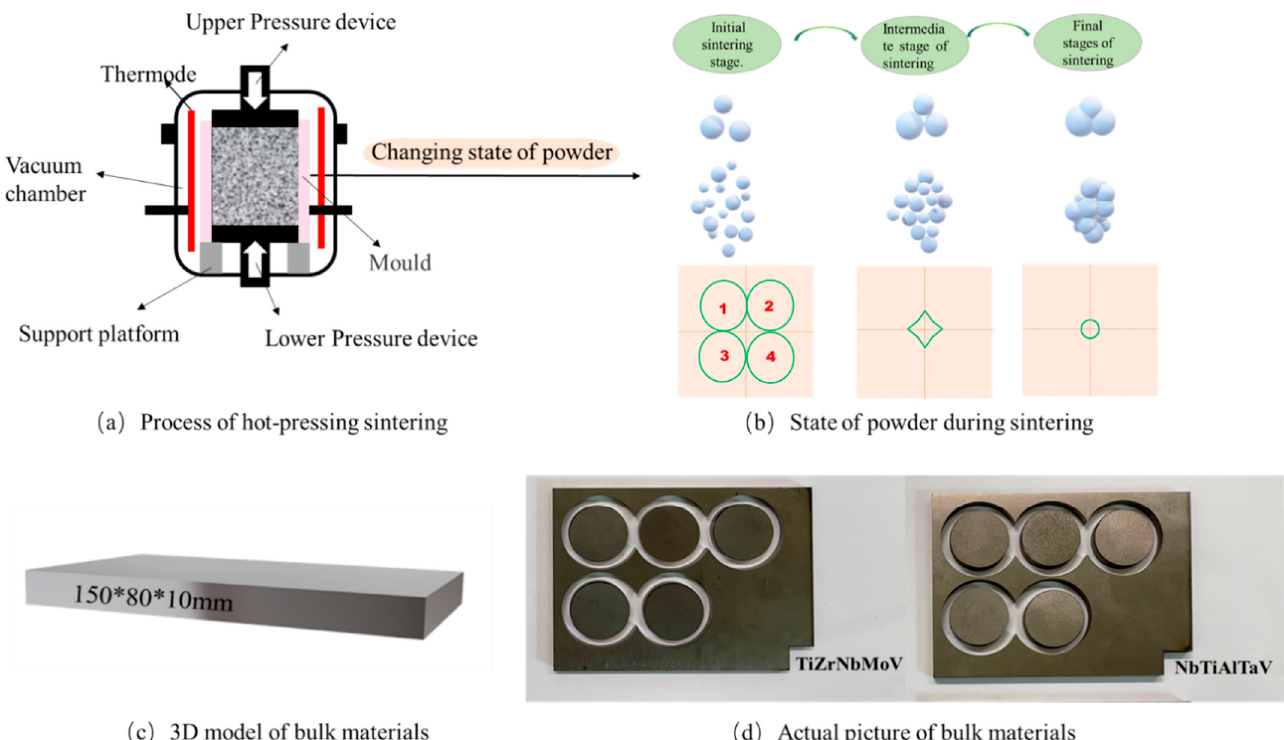
Figure 7. Simple schematic diagram of the sintering process actual picture of bulk materials. ( a ) Process of hot-pressing sintering; ( b ) state of powder during sintering; ( c ) 3D model of bulk materials; ( d ) actual picture of bulk materials.